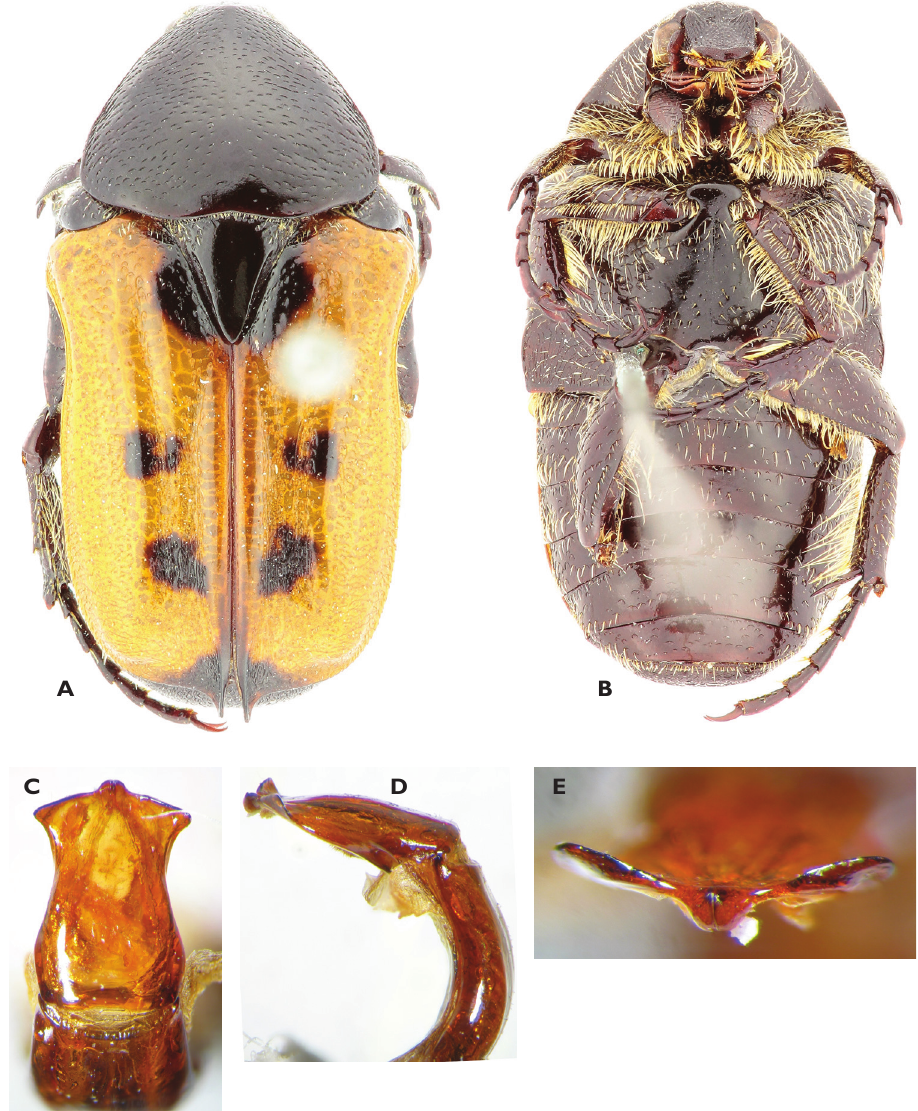
Figure 5. Atrichelaphinis ( Heterelaphinis ) quadripunctata (Lansberge, 1882), lectotype male, Somalia (MNHN). A Dorsal view B ventral view C parameres in dorsal view D parameres in lateral view E apex of